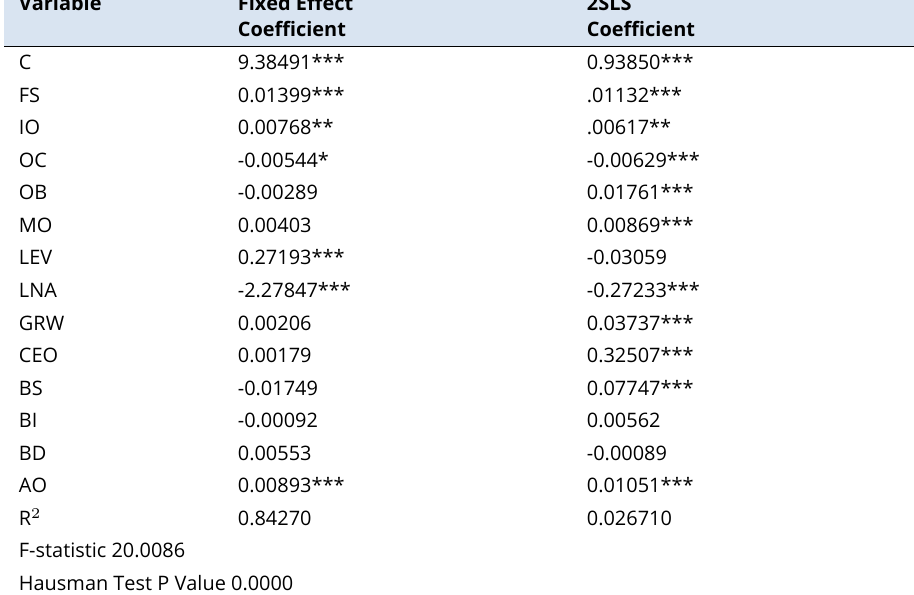
Fixed effect and 2SLS Regression of Foreign Shareholdings and Asset